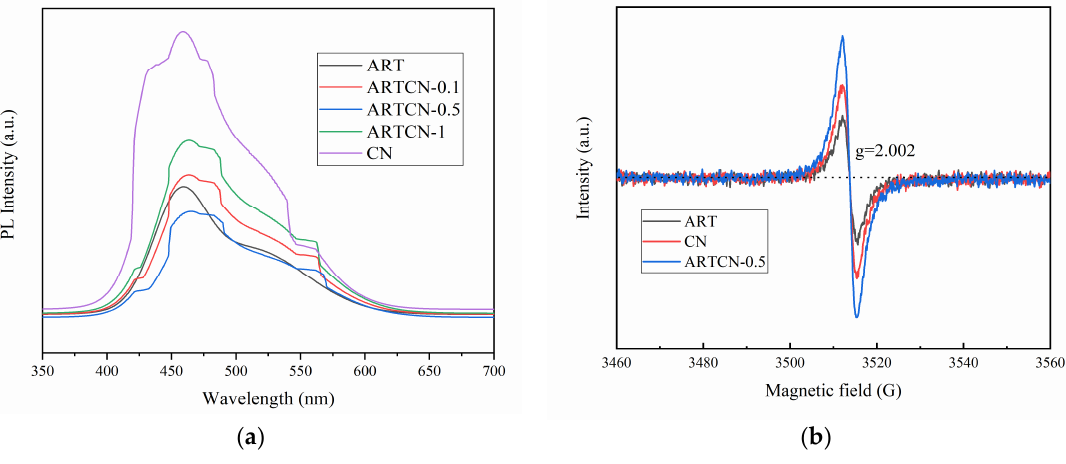
Figure 6. PL ( a ) and ( b ) EPR of the samples.